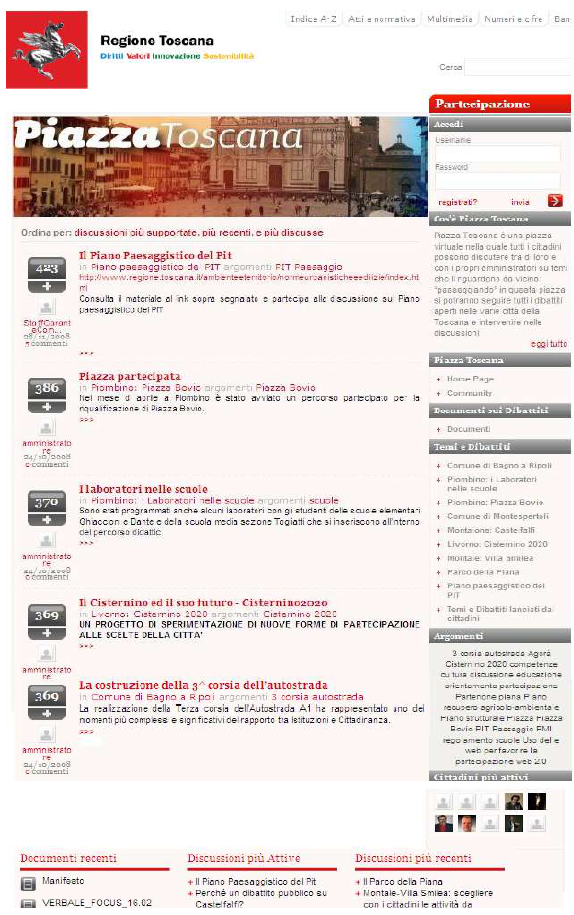
Figure 10: The “Piazza Toscana” home page